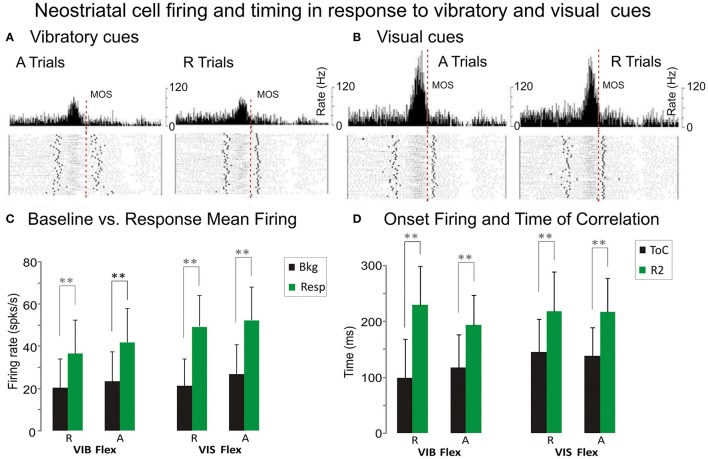
Premovement firing and timing. (A,B) Example of putaminal cell that exhibited PMA under vibratory (A) and visual (B) stimuli. Each histogram illustrates neuronal activity expressed as mean firing rate together with raster displays aligned on MOS. The left panels display the NS activity during “A” flexion trials and the right panels represent the activity during “R” flexion trials. Wrist position traces for each trial are presented at the bottom of each panel. Coefficients of Determination (CoDs) which quantify the best relationship, are: 0.920 ± 0.044 during R trials and 0.941 ± 0.024 during “A” trials (Figure 4A). CoDs for R and A trials are: 0.942 ± 0.021 and 0.954 ± 0.021, (Figure 4B) respectively. This cell exhibited increased discharge during flexion movements that occurred well before MOS. Baseline firing BKG and RESP are higher during trials following withheld rewards than during R trials. PMA onsets together with ToCs suggest that the cell may have been involved in movement initiation. (C) Comparison of premovement mean firing rates of NS cells during baseline BKG and response RESP for flexions and extensions under vibratory and visual cues. (D) Comparison of the premovement activity timing for response onsets and of best correlation time ToC for flexions and extensions under vibratory and visual cues. Statistical significance was determined using repeated measures. **p < 0.001 ANOVA, including Scheffe's post hoc test and t-test.